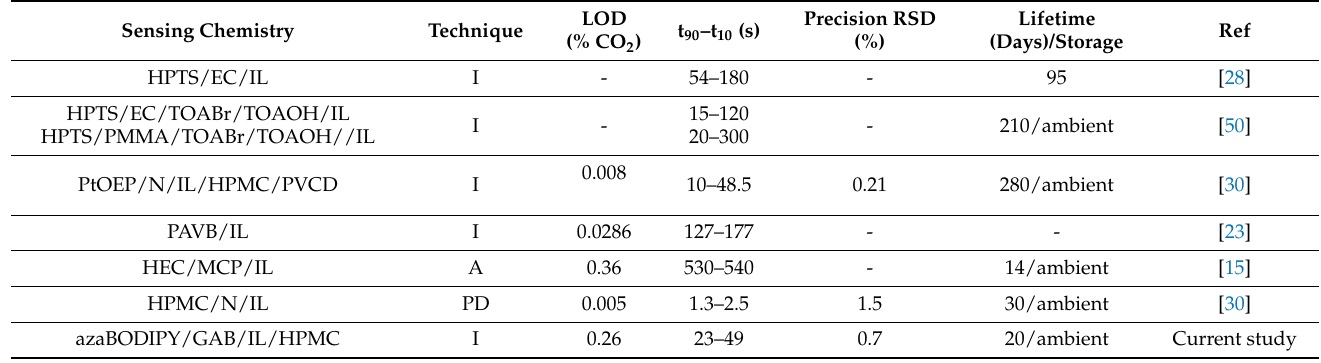
Table 3. Performance comparison of CO 2 sensing membranes based on